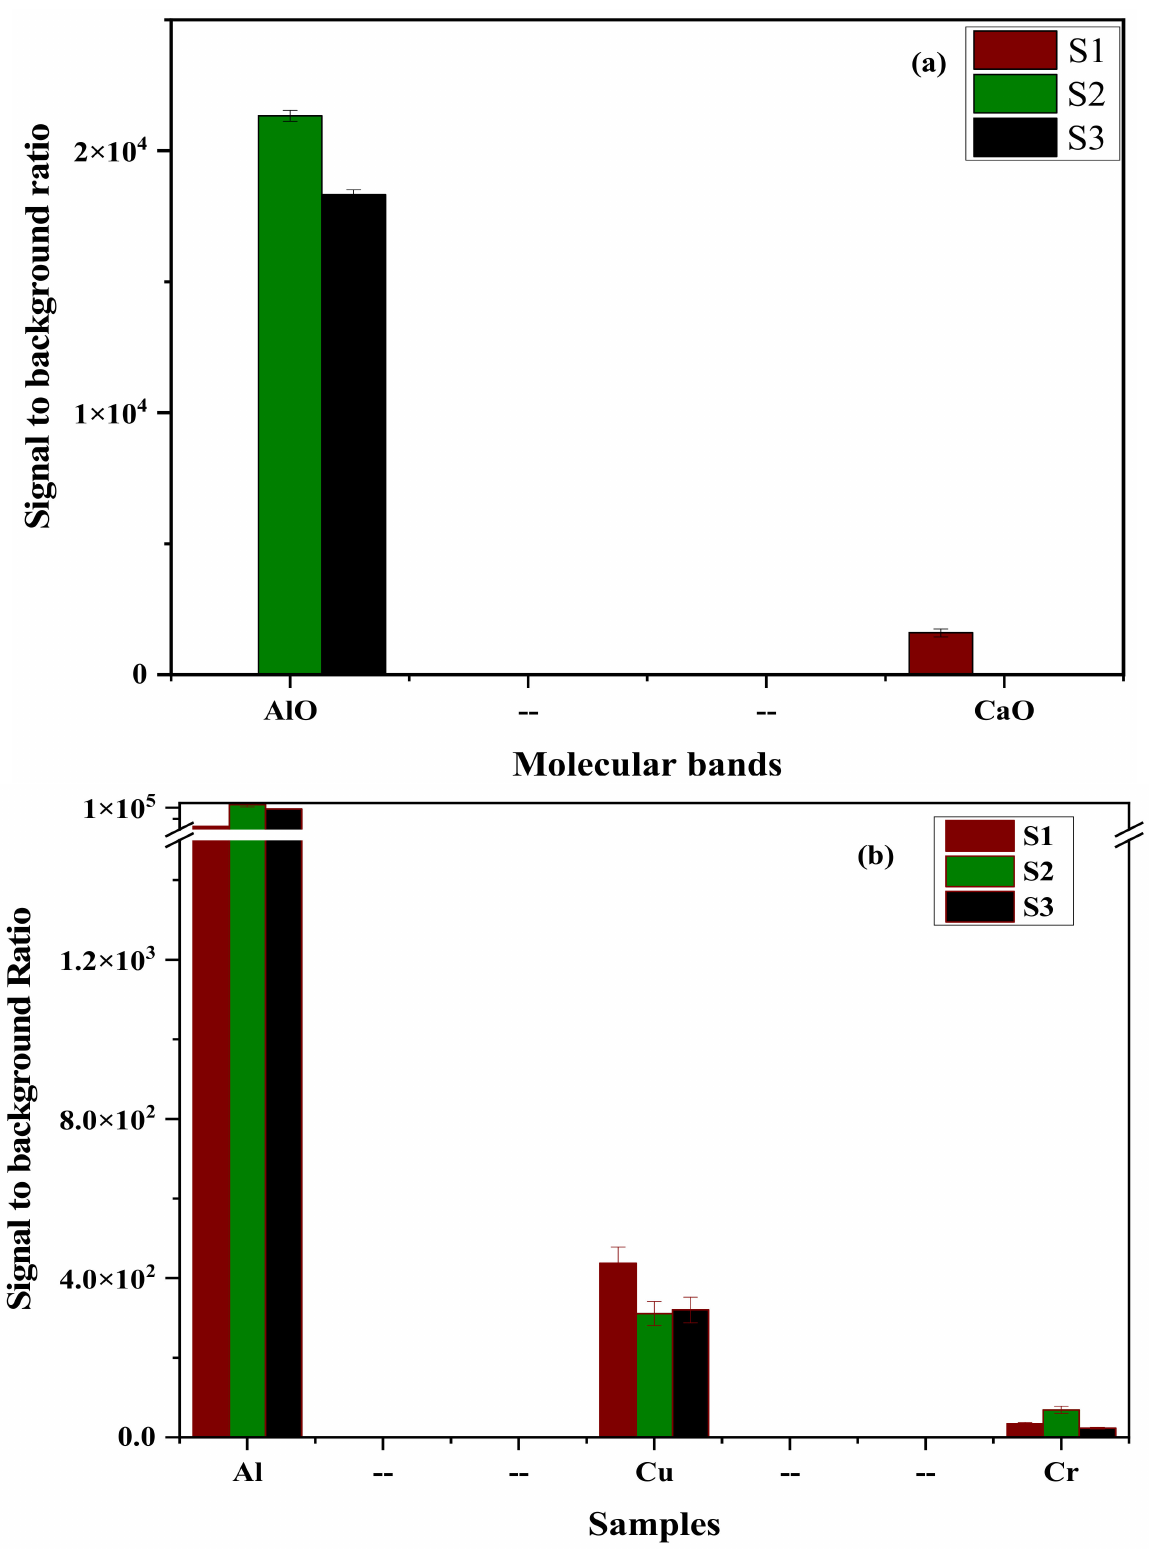
Figure 5. ( a ): Intensity bar plot of Molecular bands of AlO and CaO in different samples. ( b ): Intensity bar plot of elements Al, Cu, and Cr in different